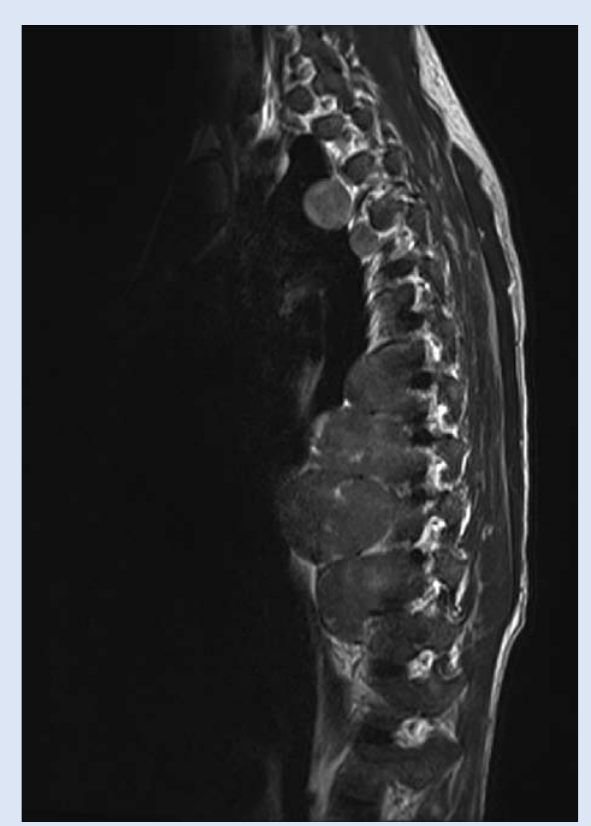
Fig. 3. Para-sagittal T1-weighted sequence demonstrates multiple lobulated masses extending from the thoracic vertebrae which are iso-intense to the vertebral bodies. The masses extend laterally and anteriorly into the posterior mediastinum.